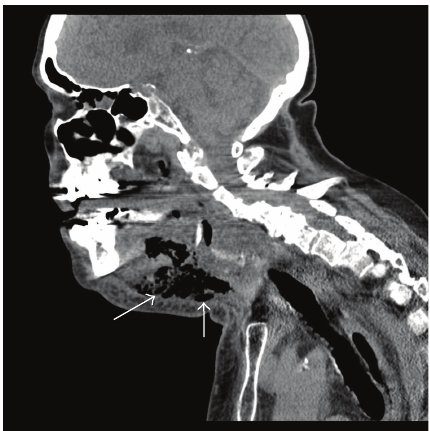
Figure 1: Sagittal CT image of patient preoperatively. Note the classic “sni ffi ng” position of patient to maximize air entry in the presence of an upper airway obstruction. White arrows point to significant gas formation in anterior cervical space.